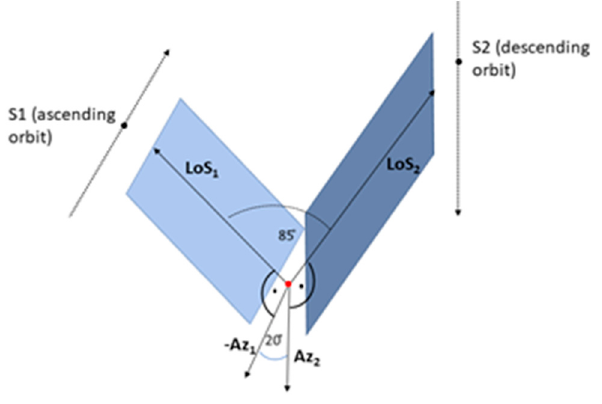
Figure 3. Multiple ST geometry—a combination of ascending and descending orbit acquisitions. The 3D-inversion strength (determinant) is high as the four vectors LoS1, LoS2, Az1, and Az2 together span a near right-angle corner.